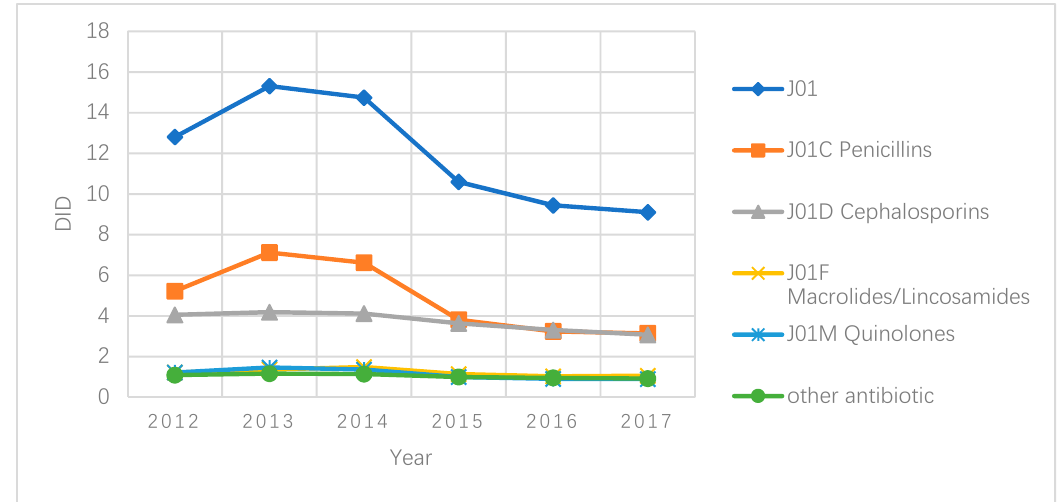
Figure 1. Antibiotic sales (DID) in primary care settings in Hubei, China, 2012–2017.